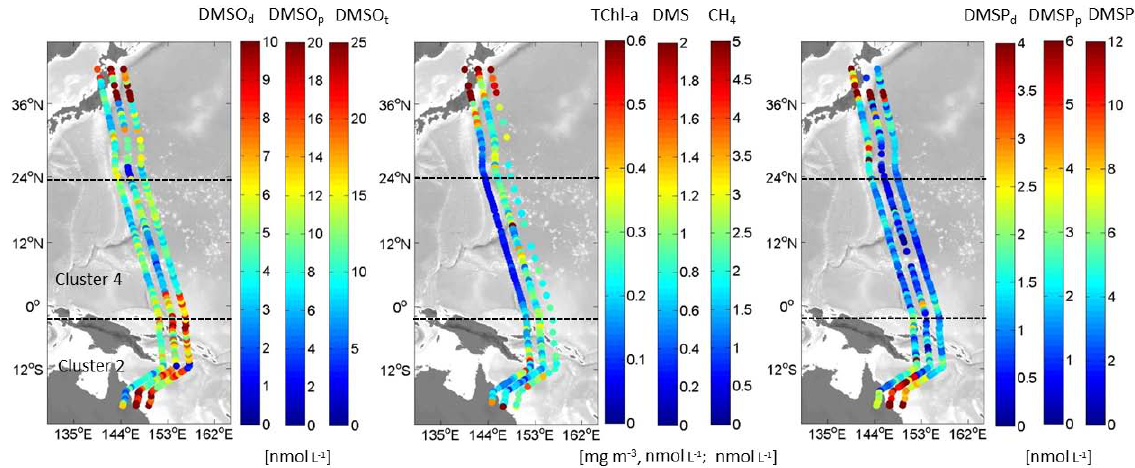
Fig. 1. Distribution of (a) DMSO (nmolL − 1 ), (b) total Chl a (mgm − 3 ) (HPLC in situ measurements), DMS, and methane (nmolL − 1 ), and (c) DMSP (nmolL − 1 ) along the cruise track. The middle line in each panel shows the exact position of the cruise track. The dashed lines show the approximate location of clusters 2 and 4. The order of the colour bars corresponds to the order of the individual coloured cruise tracks in the figure